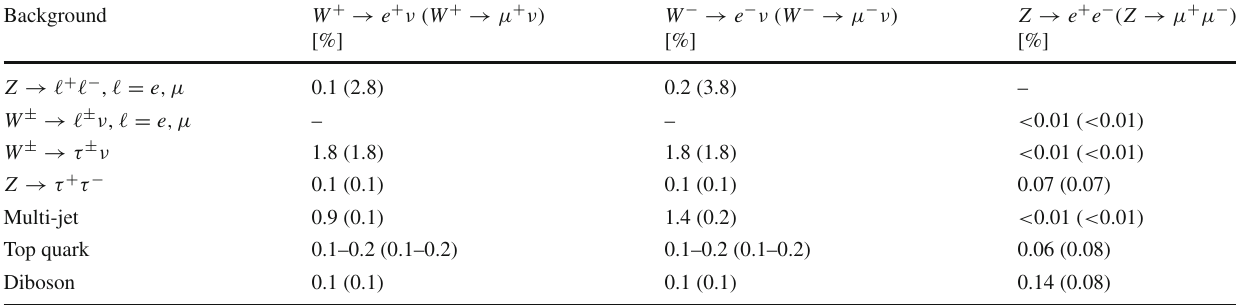
Table 1 Background contributions as a percentage of the total for the W + , W − and Z candidate samples in the electron (muon) channels